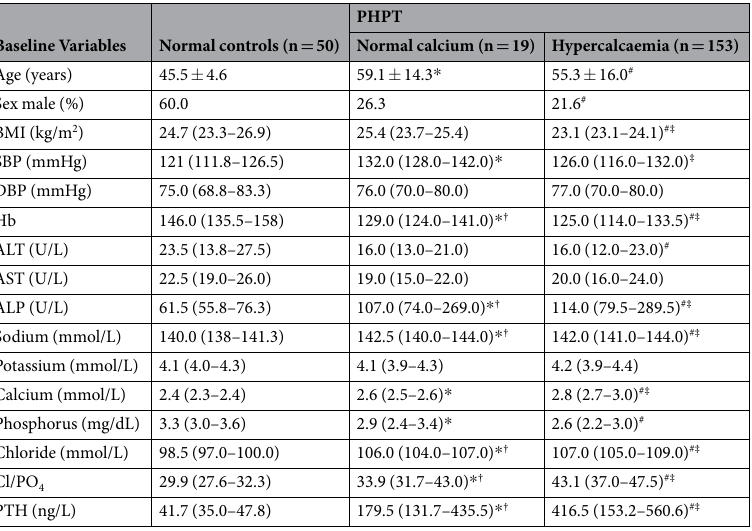
Table 1. Baseline characteristics of the primary hyperparathyroidism (PHPT) and normal control groups. Data are the means ± SD or medians (interquartile range). * P < 0.05 NPHPT subjects vs . normal controls; † P < 0.05 N P HPT subjects vs . normal controls after adjusting for age and sex; # P < 0.05 hypercalcaemic PHPT group vs . normal controls; ‡ P < 0.05 hypercalcaemic PHPT group vs . normal controls after adjusting for age and sex. BMI, body mass index; SBP, systolic blood pressure; DBP, diastolic blood pressure; Hb, haemoglobin; ALT, alanine aminotransferase; AST, aspartate aminotransferase; ALP, alkaline phosphatase; PTH, parathyroid hormone; Cl/ PO 4 , chloride/phosphorus